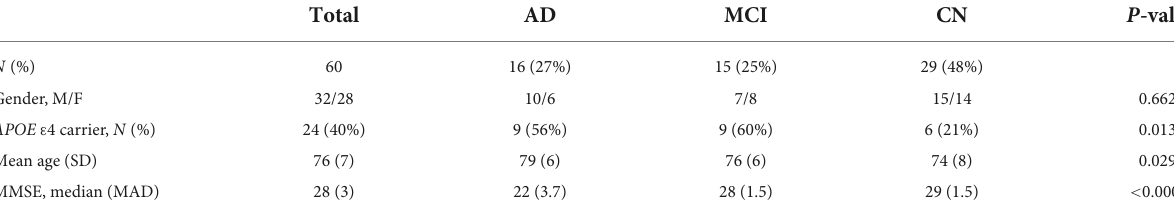
TABLE 1 Demographic data of SANDs cohort.